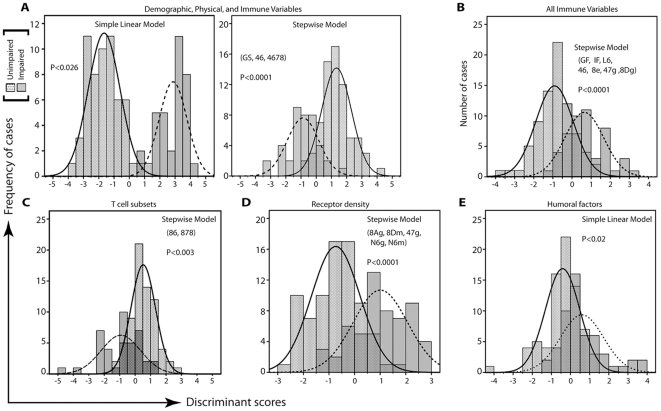
Group assignment of CHS All Stars elders based on 3MSE/ADL scores is discriminated by physical and immune parameters.Discriminant function analysis was performed on collated physical, demographic, and immunological data (see 
Table 1
 and Tables S1, S2, S3, S4). Using all variables, both simple and stepwise models showed significant separation between impaired and unimpaired groups around the centroid, indicated as the zero-mark on the x-axis (A). Using only immune variables (B), or T cell subset frequency (C), or receptor density on T cells (D) stepwise models showed significant separation between the two groups despite some overlap. When humoral factors were used only in the analysis, only a simple linear model could be constructed (E). Significant contributing variables to models shown in B, C, D were: gait speed (GS); the T cell subsets CD4+CD56+ (46), CD4+CD28nullCD56+CD57+ (4678), CD8+CD158e+ (8e), CD8+CD56+ (86), and CD8+CD28nullCD57+ (878); GMFI of CD57 on CD4 T cells (47 g); the GMFI of NKG2D (8 Dg) and NKG2A (8 Ag) on CD8 T cells; the GMFI (N6 g) and MFI (N6 m) of CD56 on DN T cells; the MFI of NKG2D on CD8 T cells (8 Dm); and the humoral factors GMCSF (GF), IFN-γ (IF), IL-6 (L6), and IL-12p70 (L12). The indicated p-values were based on χ2 test of Wilk's lambda discriminant statistic.